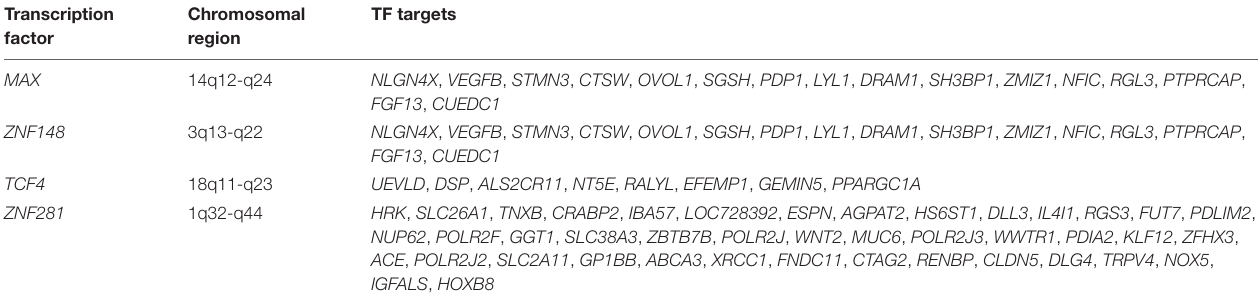
TABLE 2 | Transcription factors of interest, identified from condition-specific modules in normal, MGUS, and SMM samples. Transcription